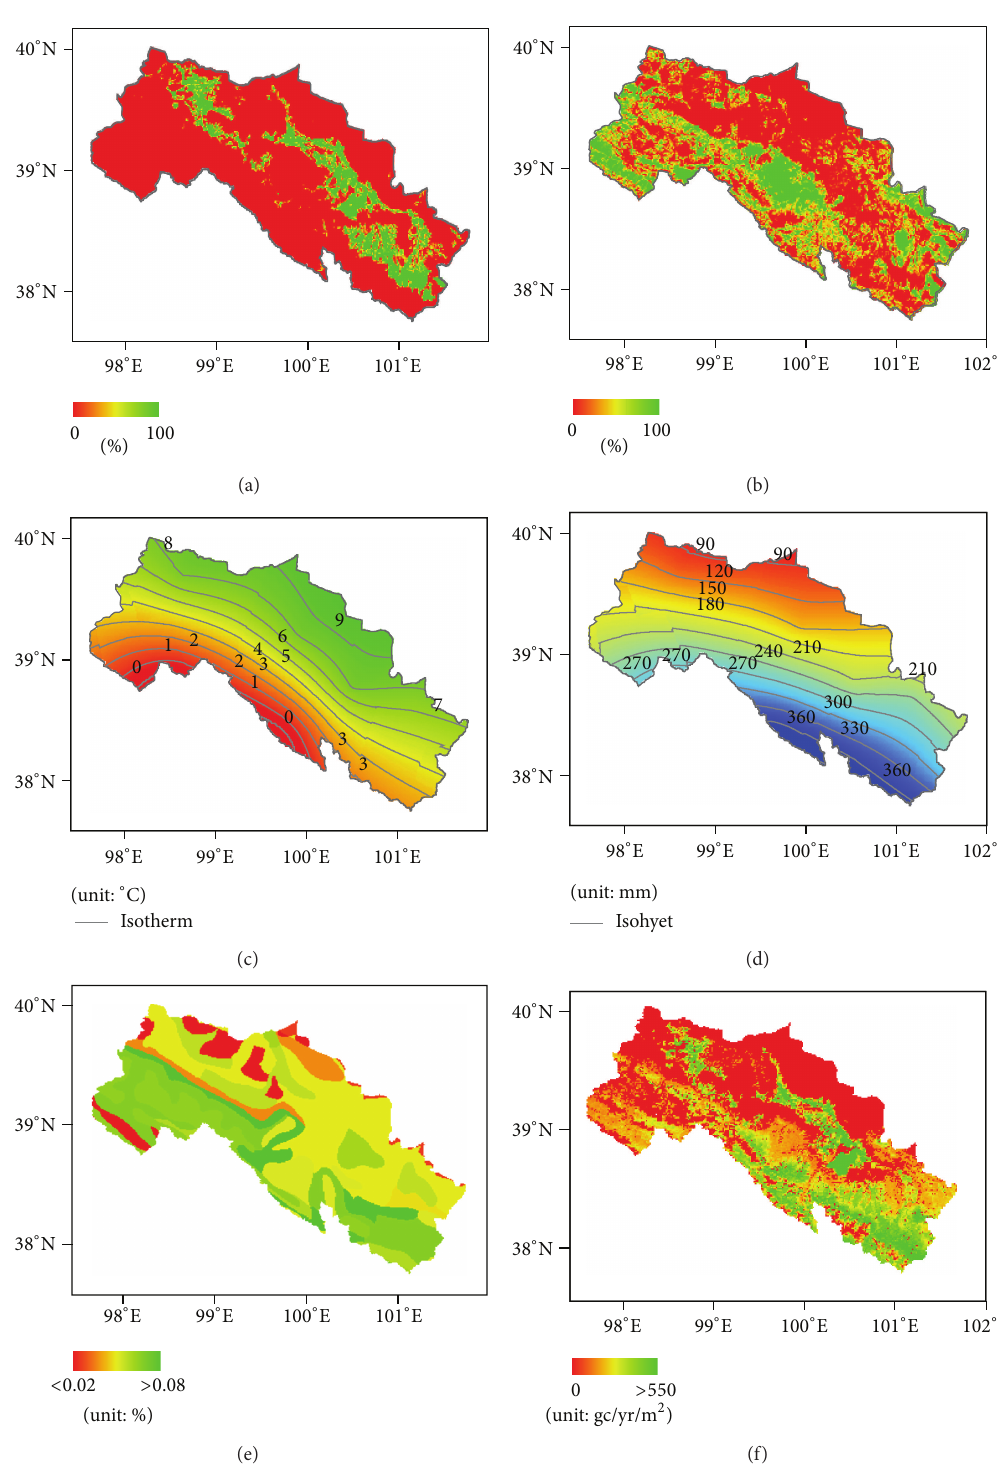
Figure 4: Spatial dispersion and characterization of the ecosystem services indicators, (a) cultivated land percentage, (b) grassland area percentage, (c) air temperature, (d) precipitation, (e) soil phosphorus content, and (f) net primary